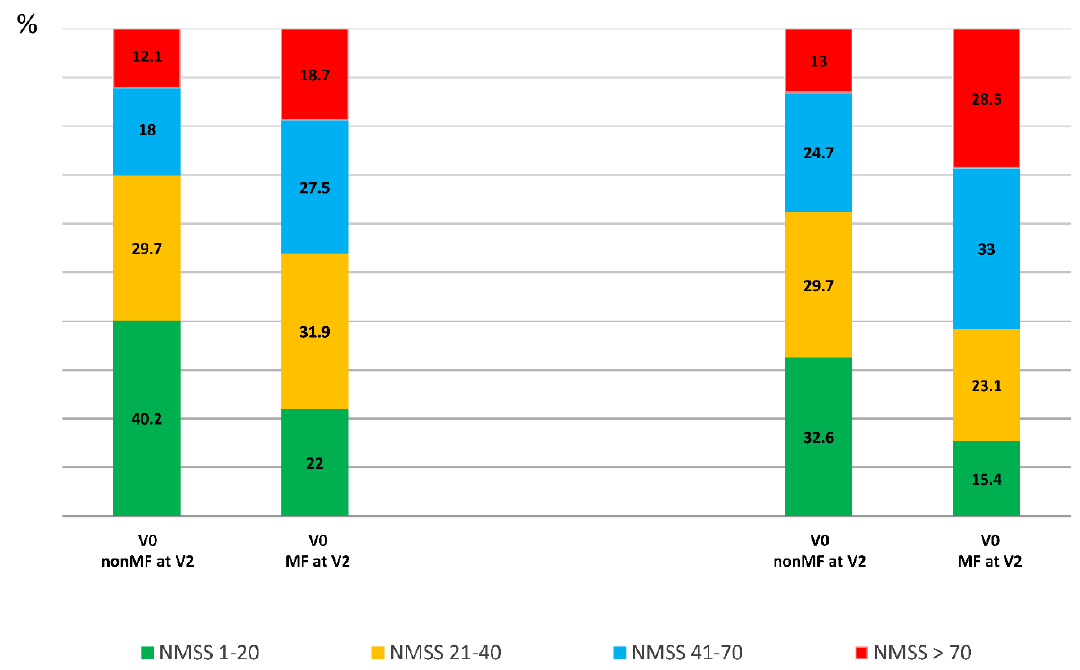
Figure 2. Frequency of patients with mild (NMSS 1–20), moderate (NMSS 21–40), severe (NMSS 41– 70), and very severe (NMSS > 70) NMS burden at V0 and at V2 considering two groups: